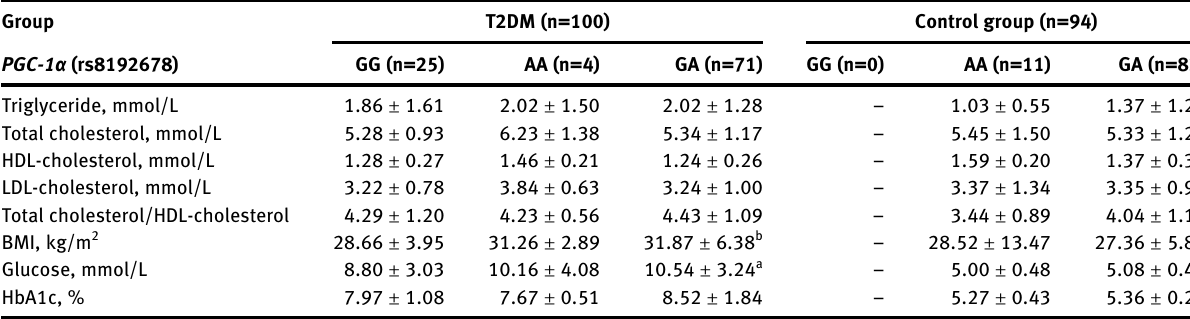
Table  : Distribution of the PGC-  α (rs  ) genotypes according to biochemical pro fi les type  diabetes mellitus patient and control groups.